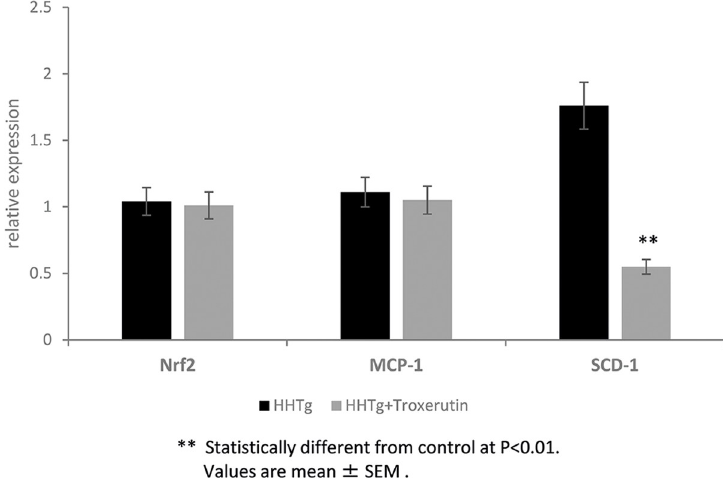
Fig 2. Hepatic expression of NRF2, MCP-1 and SCD-1 genes in HHTg rats treated with troxerutin compared to controls. Data are measured in triplets using n = 8 rats per group per analyses. Data are expressed as means (SEM) and analysed by two-tailed unpaired Student’s t test. �� p < 0.01.